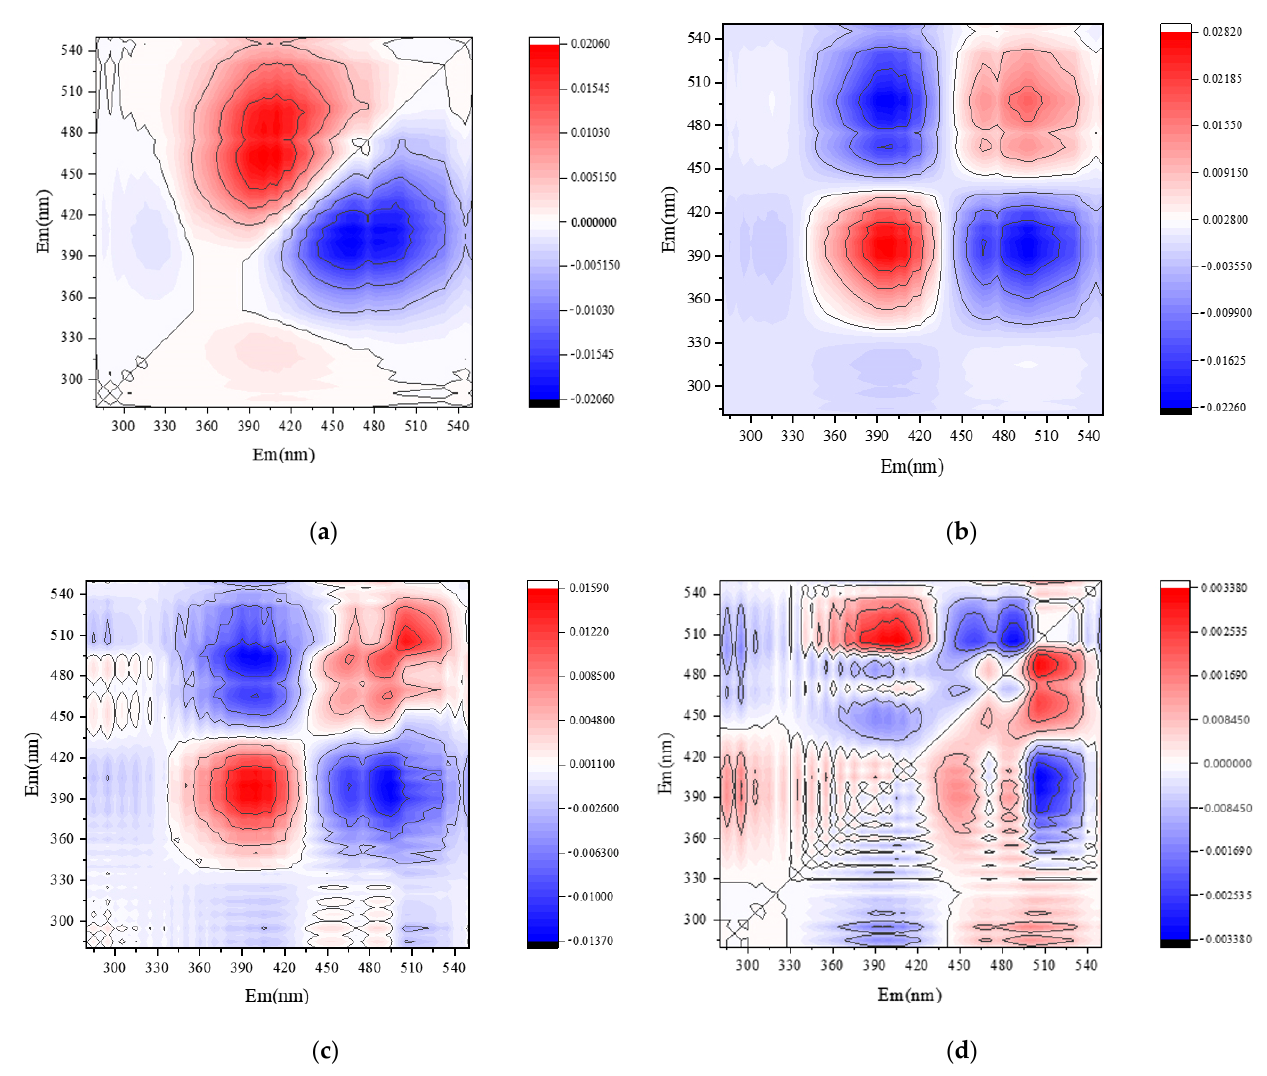
Figure 6. Two-dimensional correlation analysis of soil DOM fluorescence components. Note: CSCD and AI were conventional and aerated subsurface drip irrigation treatments, respectively. ( a ) Syn- chronous fluorescence spectra under CSDI. ( b ) Asynchronous fluorescence spectra under CSDI. ( c ) Synchronous fluorescence spectra under AI. ( d ) Asynchronous fluorescence spectra under AI. Table 6. The change order table of DOM components with time as disturbance factor in CSDI.